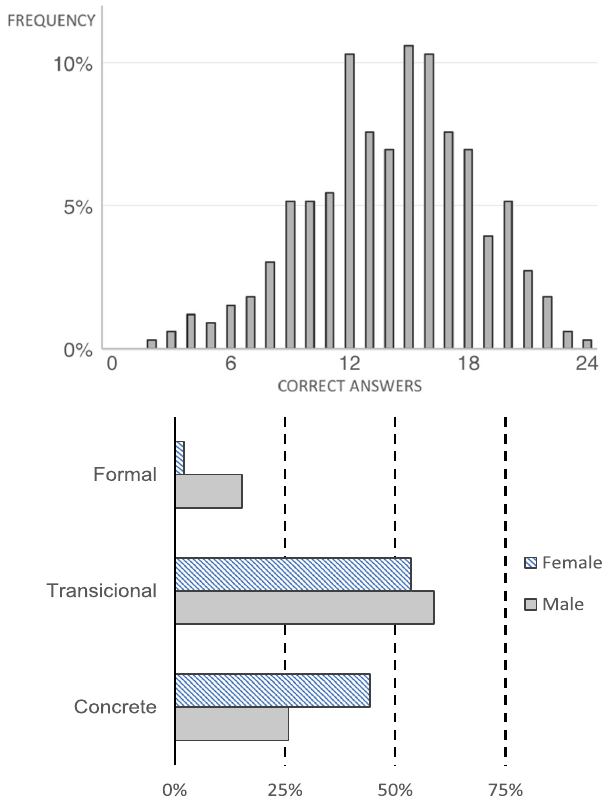
FIG. 2. Top: Distribution of students as a function of the number of correct answers. Bottom: Categorization of scientific reasoning level for introductory physics students, experimental, and control groups combined (Male: N ¼ 228 , Female: N ¼ 76 ).